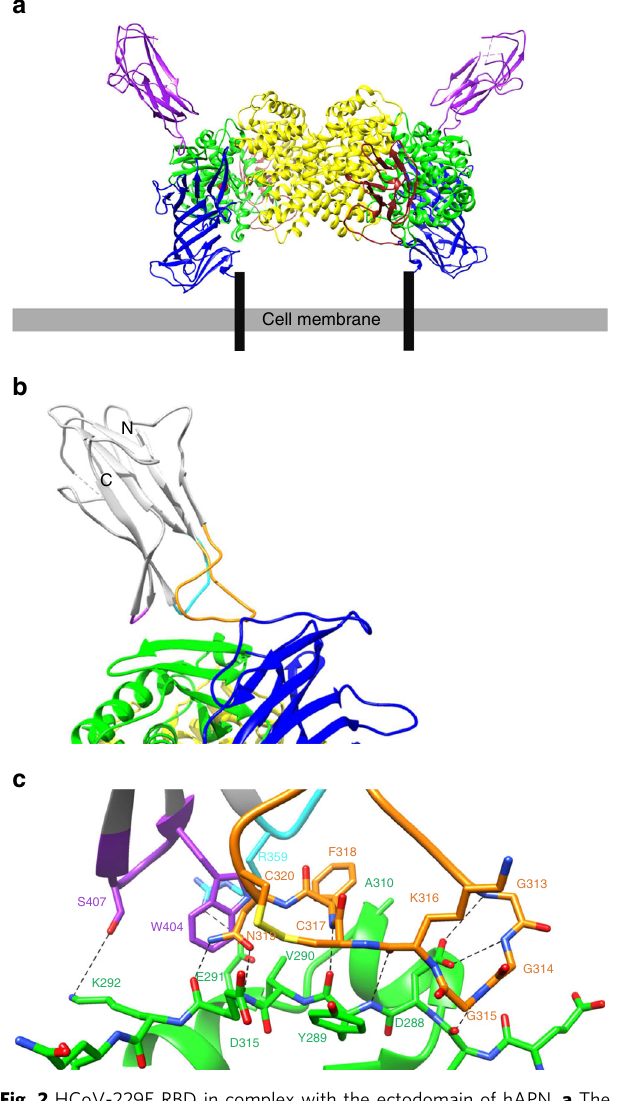
Fig. 2 HCoV-229E RBD in complex with the ectodomain of hAPN. a The complex between dimeric hAPN (domain I: blue, domain II: green, domain III: brown, and domain IV: yellow) and the HCoV-229E RBD (purple) is depicted in its likely orientation relative to the plasma membrane. The hAPN peptide and zinc ion (red spheres) binding sites are located inside a cavity distant from the virus binding site. Black bars represent the hAPN N- terminal transmembrane region. b Ribbon representation of the HCoV- 229E RBD (gray) in complex with hAPN (same coloring as in a ). The three receptor-binding loops are colored, orange (loop 1), cyan (loop 2), and purple (loop 3). N and C label the N- and C-termini of the RBD. c Atomic details of the interaction at the binding interface. Hydrogen bonds and salt bridges are indicated by dashed lines. Red and blue correspond to oxygen and nitrogen atoms, respectively. Loop and hAPN coloring as in